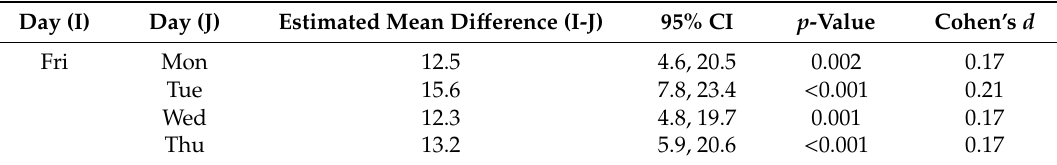
Table A7. Pairwise comparisons of significant estimated mean di ff erences in seated transport (minutes) between weekdays A